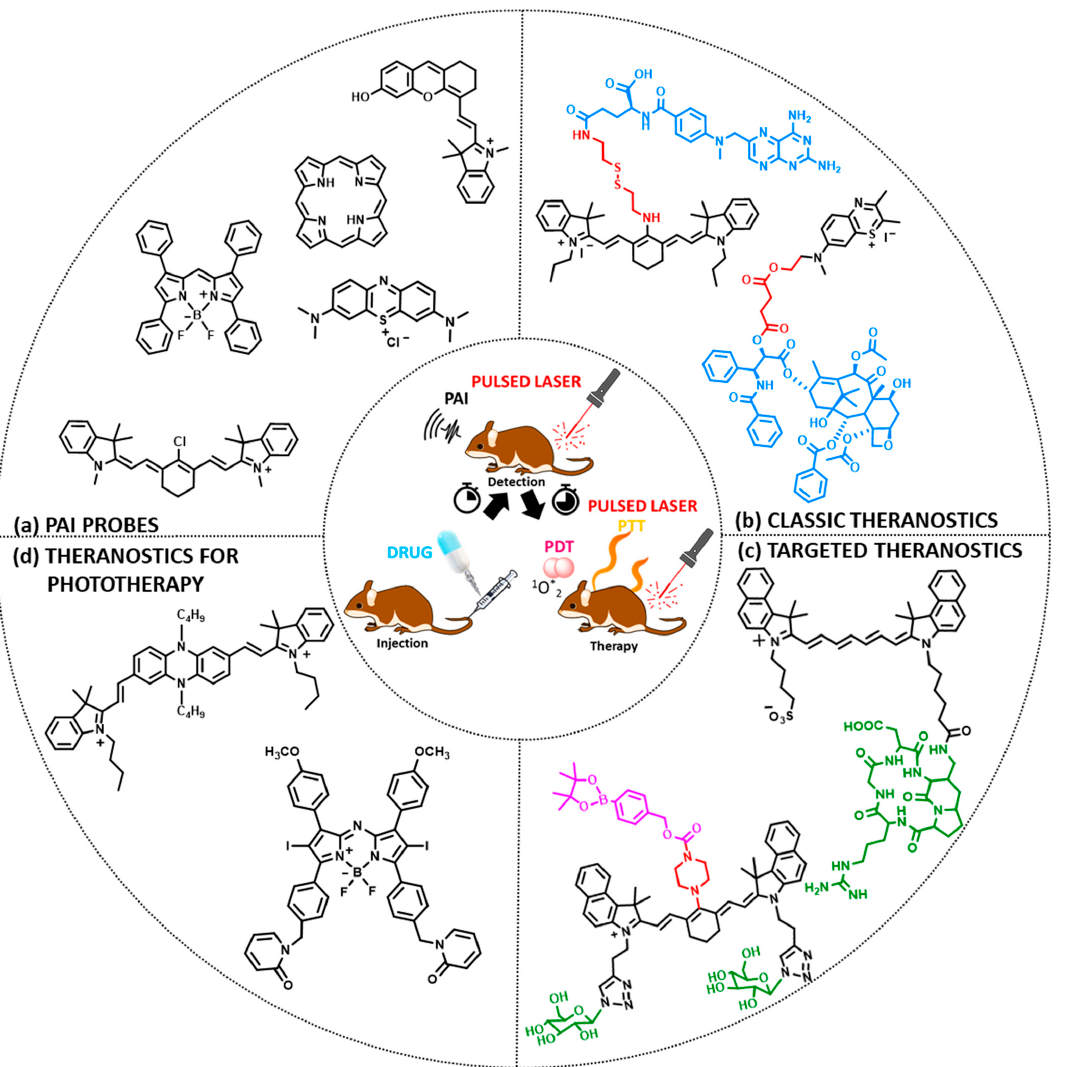
Figure 1. Representative examples of molecules utilized for photoacoustic purposes, that are de- scribed in this review. ( a ) Photoacoustic imaging (PAI) probes, ( b ) “classic” theranostics consisting of a drug and a dye tethered through various linkers, ( c ) targeted theranostic agents utilizing a tumor- homing element, and ( d ) theranostics utilized for simultaneous PAI and phototherapy. Photoacoustic agents are colored black, drugs are colored in light blue, targeting moieties are colored in green, the trigger group is colored in purple, and linkers are colored in red. PAI = Photo acoustic imaging; PTT = Photothermal therapy; PDT = Photodynamic therapy. Some of the illustrated components might have a dual role (e.g., indocyanine green dye analogs shown in black color in ( c ) offer both imaging and therapeutic